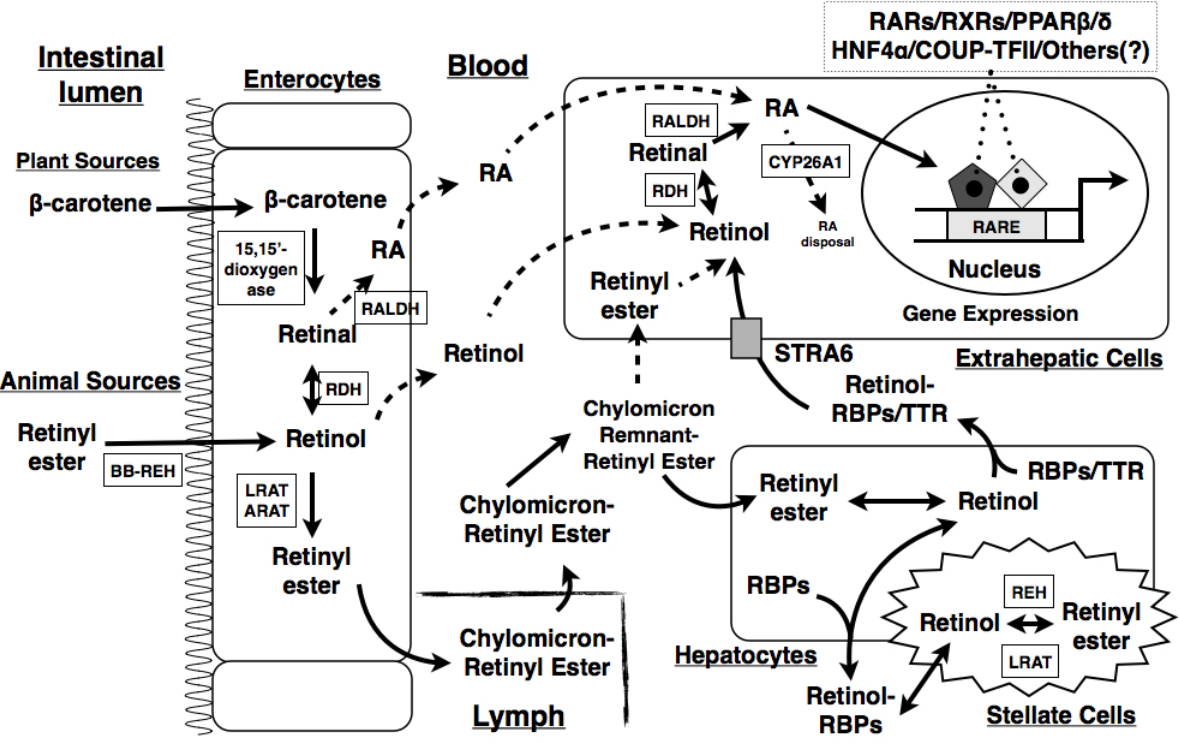
Figure 1. Schematic representation of vitamin A (VA) digestion, absorption, transport, and metabolism in the body. Dietary VA from plant and animal sources is digested in the intestinal lumen and absorbed by enterocytes via different mechanisms. Within the enterocytes, the dietary VA is converted into retinyl esters, which are packaged into chylomicrons for the secretion into the lymph and eventually enter the circulation. The lipoprotein lipase hydrolyzes triglycerides (TGs) on the chylomicrons to produce chylomicron remnants. The retinyl ester-containing chylomicron remnants are eventually taken up by hepatocytes, where the retinyl esters are again hydrolyzed into retinol. The released retinol can be transported to target cells and catabolized into retinal, retinoic acid (RA), or other metabolites. Excessive retinol is re-esterified into retinyl esters, which are stored in stellate cells. BB-REH, brush-border retinyl ester hydrolase; LRAT, lecithin:retinol acyltransferase; ARAT, acyl-CoA:retinol acyltransferase; RBP, retinol binding protein; RDH, retinol dehydrogenase; RALDH, retinal dehydrogenase; REH, retinol ester hydrolase; STRA6, stimulated by retinoic acid 6; RA, retinoic acid; RARE, retinoic acid responsive element; RAR, retinoic acid receptor; RXR, retinoid X receptor; TTR, transthyretin; PPAR, peroxisome proliferator-activated receptor; HNF4 α , hepatocyte nuclear factor 4 α ; COUP-TFII, chicken ovalbumin up-stream transcription factor